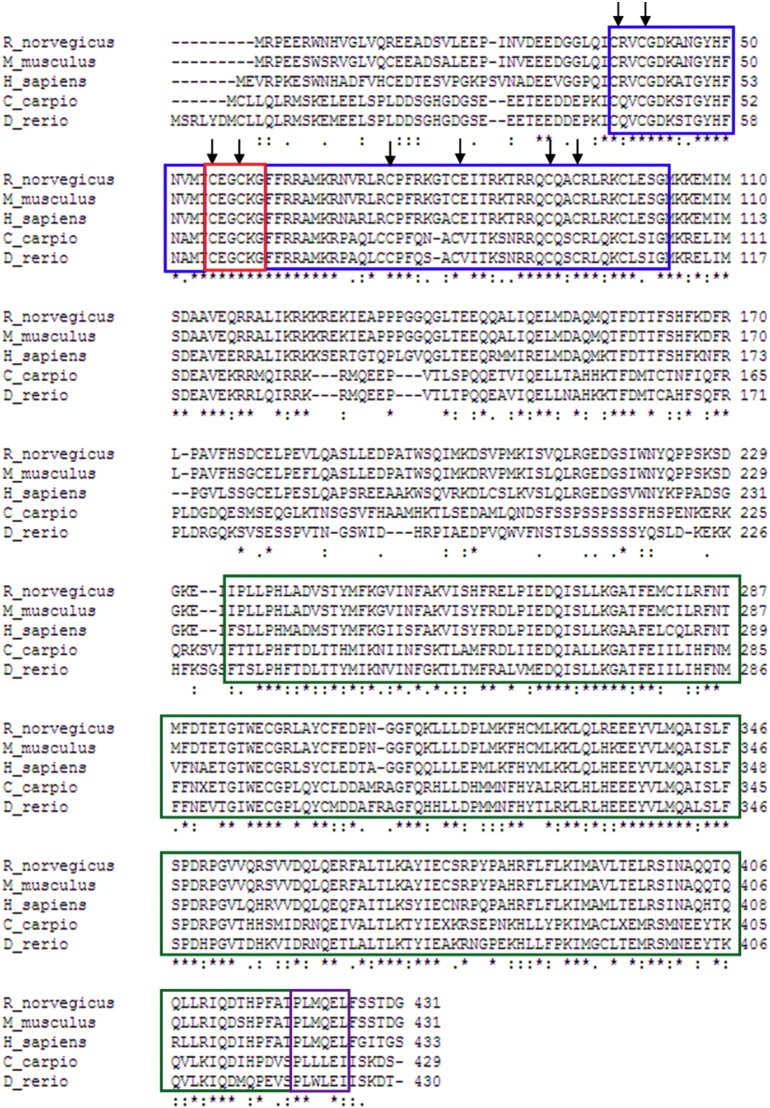
cPXR amino acid sequence aligned with PXR sequences of other animal species. The highly conserved DBD (blue outline) consists of two C4-type zinc fingers and includes a P-box motif (red outline). The conserved LBD (green outline) includes the AF-2 motif (purple outline). Accession numbers of sequences used for alignment: AAH17304 (H. sapiens); NP_443212 (R. norvegicus); NP_035066 (M. musculus); NP_001092087 (D. rerio).